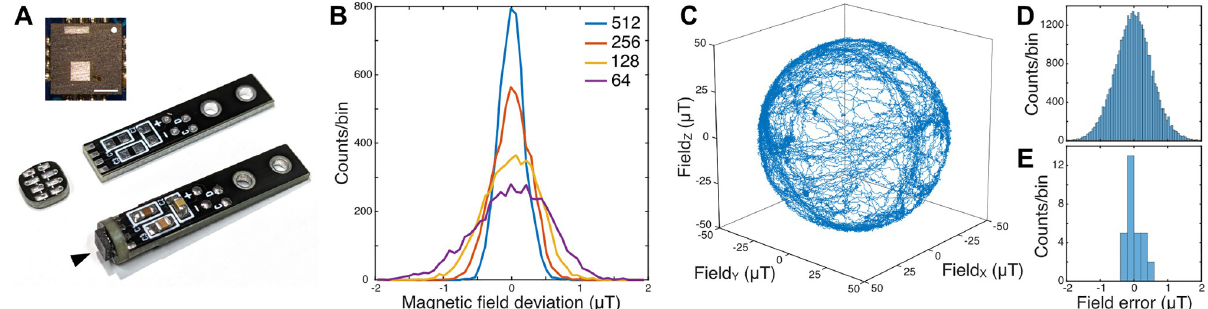
Fig 2. Miniature vector magnetometer. A: Two-part sensor board design. The QMC5883L magnetic sensor is marked by an arrowhead. Sensor 3 mm x 3 mm. Inset top left: Position of the sensor dies inside the QMC5883L package, top view onto the package. White dot marks pin 1. Inset scale bar = 1 mm B. Noise floor of an exemplary QMC5883L for the four available oversampling settings 64x–512x. C. Trajectory of rotating the sensor in the natural earth magnetic field (49 μ T) for approximately 3 minutes after calibration on the smallest oversampling setting. D. Residuals between the trajectory data in C and a homogeneous natural field. E: Residuals as in D averaged over 15 s to reduce noise for 30 stationary orientations in the natural magnetic field.